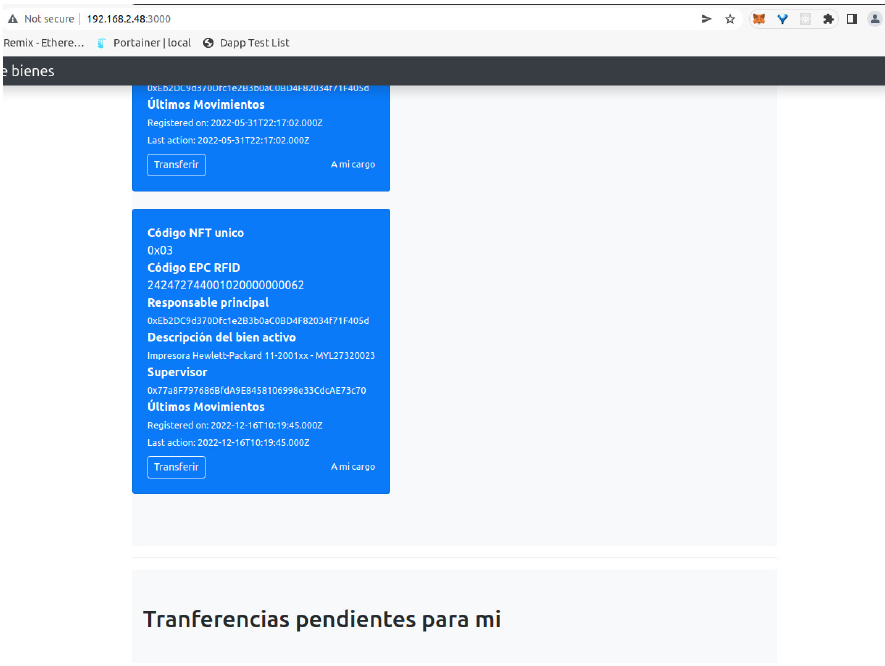
Figure 9. DAPP new register entry in the list of owned assets for the current active account in MetaMask, displayed in Spanish